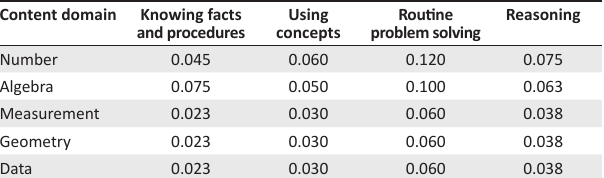
TABLE 6 : Derived target percentages of TIMSS 2003 mathematics assessment devoted to content and cognitive domain by grade level.